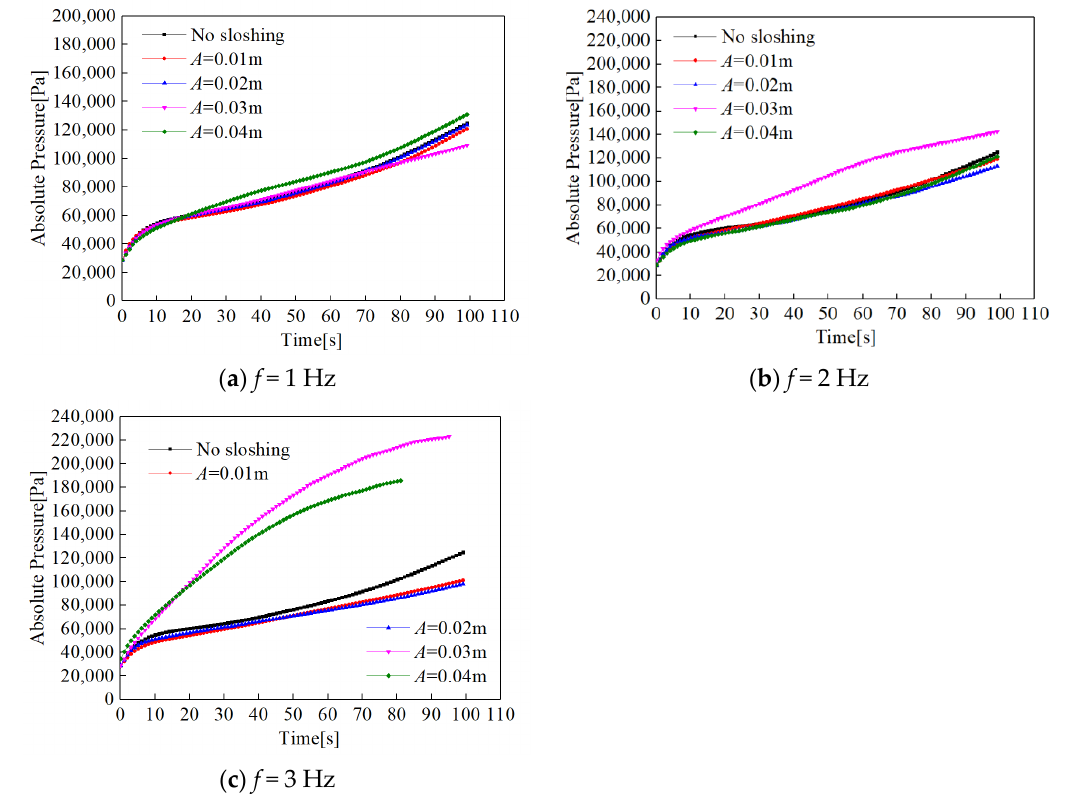
Figure 10. Pressure responses of the no-vent filling process under different sloshing amplitudes with the condition of sloshing frequency ( a ) f = 1 Hz, ( b ) f = 2 Hz, and ( c ) f = 3 Hz.